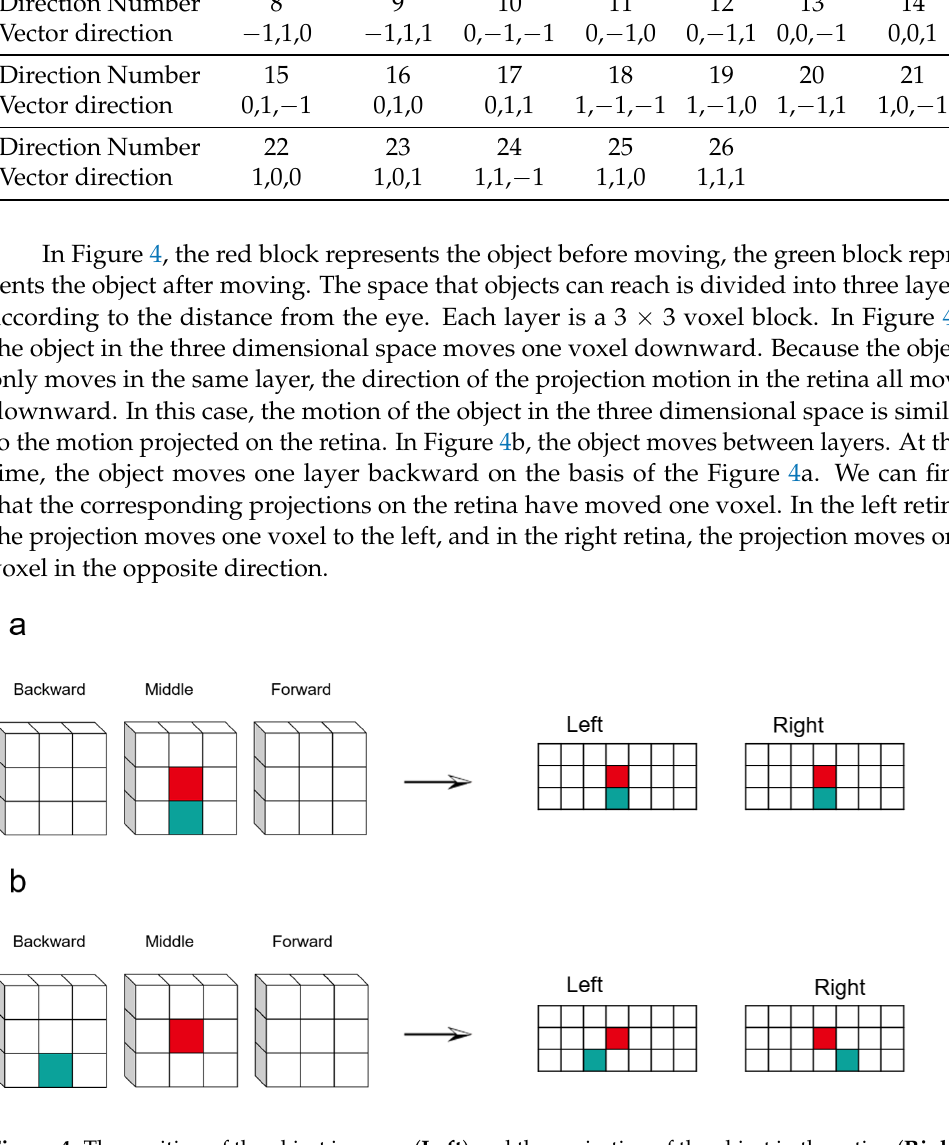
Figure 4. The position of the object in space ( Left ) and the projection of the object in the retina ( Right ), twenty-six local motion direction detection neurons are used to detect region from (1,1) to (3,7) over the two-dimensional retina receptive field. The red block represents the object before moving and the green block represents the object after